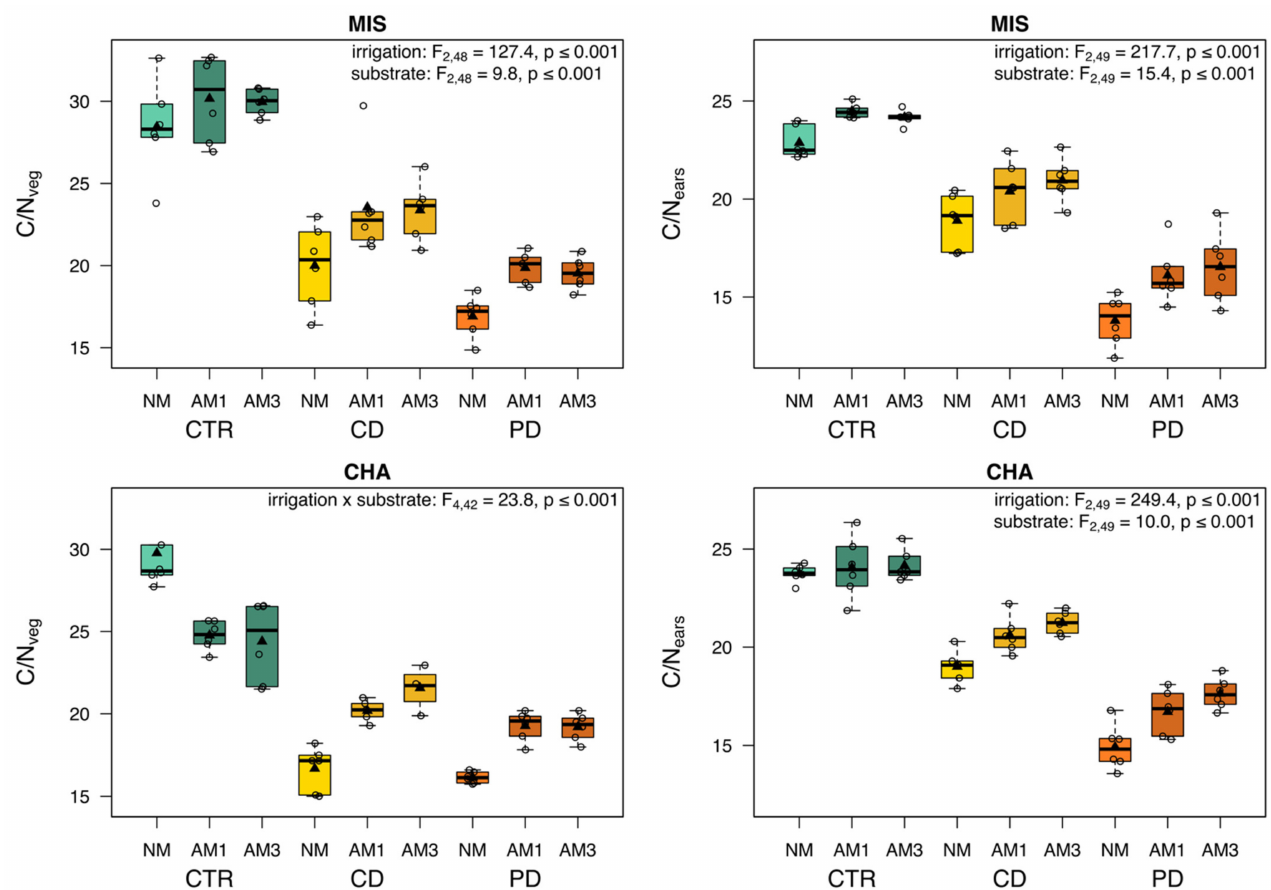
Figure 6. C/N ratio of vegetative biomass (stems and leaves) and ears from two wheat cultivars [ Triticum aestivum ; Chamsin (CHA), Mistral (MIS)] 67 days post sowing. Cultivation occurred under different irrigation conditions [control (CTR), continuous drought (CD) and pulsed drought (PD), factor: irrigation]. Plants were either non-mycorrhized (NM), mycorrhized with a single fungus (AM1; Rhizoglomus irregulare ) or with a mixture of three fungi (AM3; R. irregulare, Funneliformis mosseae, F. caledonium ) (factor: substrate). Data are given as box–whisker plots with interquartile ranges (IQR; boxes) including medians (horizontal lines), means (triangles) and whiskers (extending to the most extreme data points with maximum 1.5 times the IQR); individual values are given as open circles. The results of linear models are shown comprising the remaining significant terms after model simplification; n =